Question: Provide a publication-style caption for this figure.
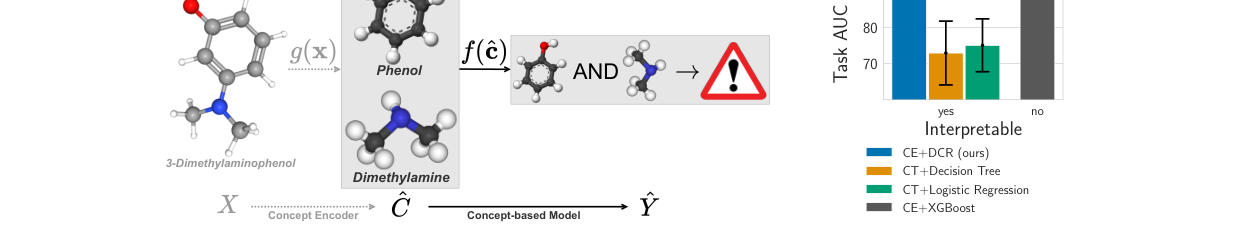
Answer: (a) An interpretable concept-based model f maps concepts ˆC to tasks ˆY generating an interpretable rule. When input features are not semantically meaningful, a concept encoder g can map raw features to a concept space. (b) The proposed approach (DCR) outperforms interpretable concept-based models in the Dot dataset. CE stands for concept embeddings and CT for concept truth values.